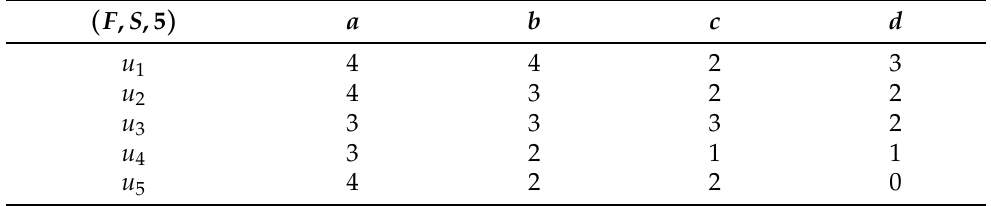
Table 1. Table 1. The 5-Soft Set of ( F , S ,5 ) . ( F , S , 5